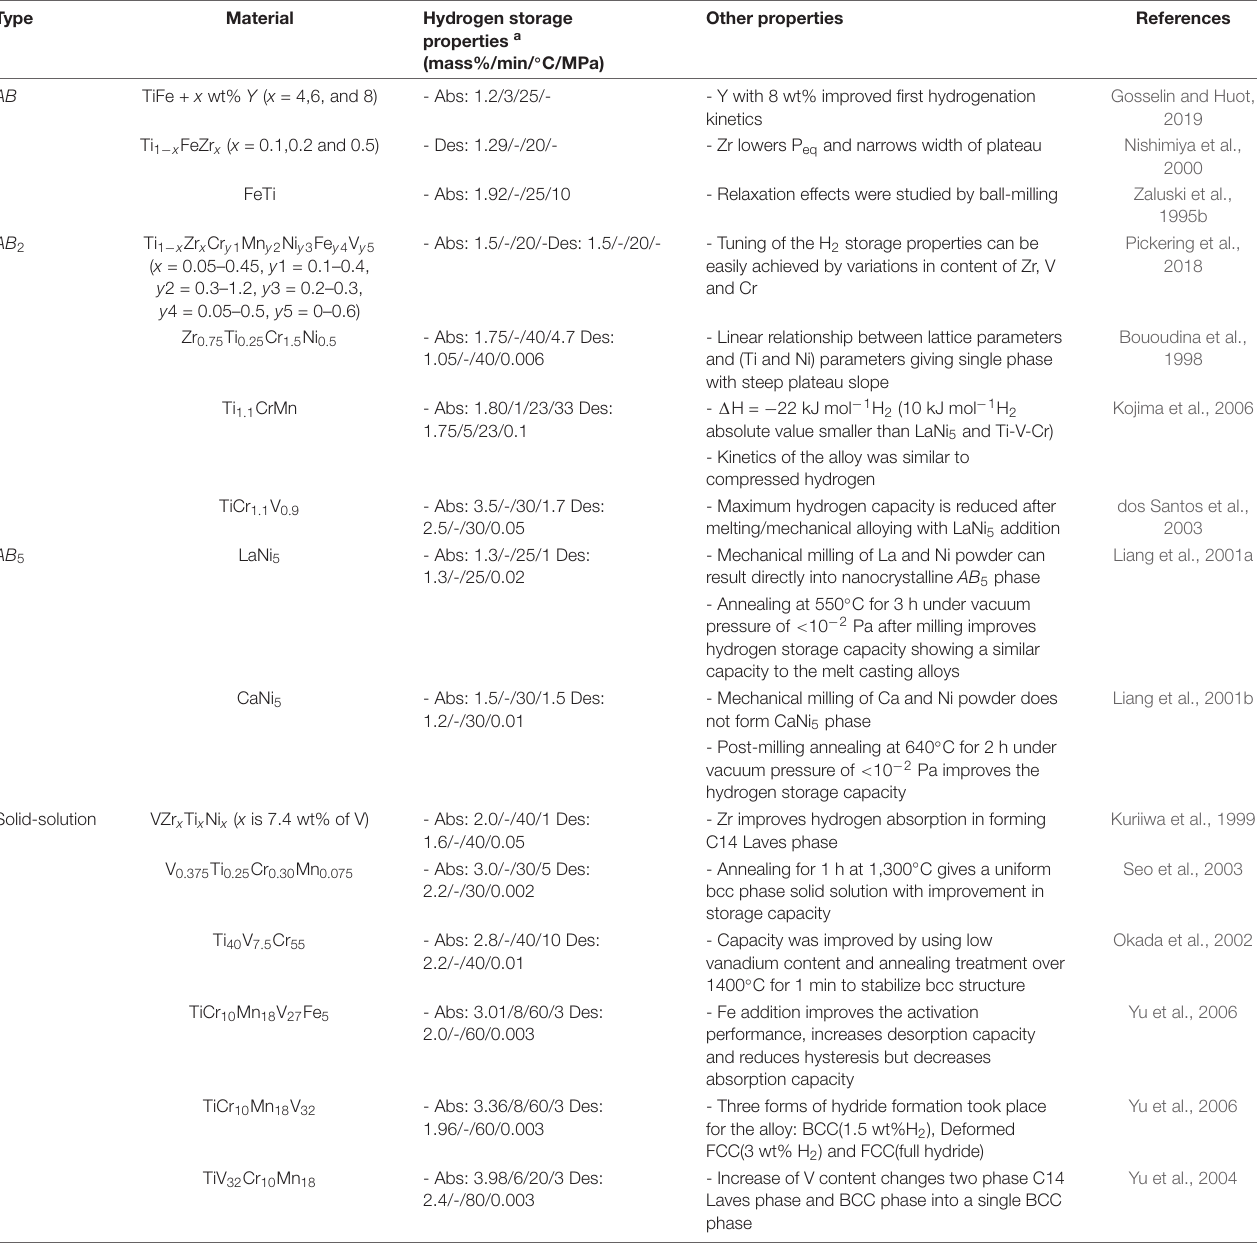
TABLE 5 | Examples of Metal Hydrides and their properties (Sakintuna et al.,